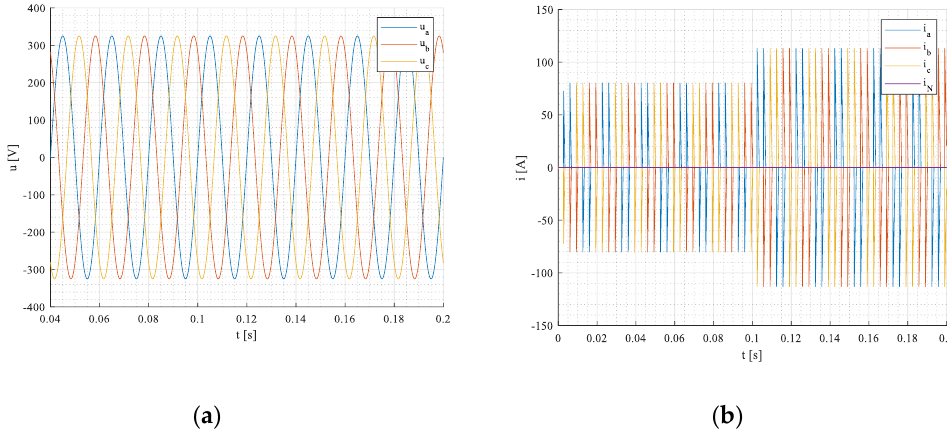
Figure 14. Network voltages ( a ) and currents ( b ) in 𝑎, 𝑏, 𝑐 - coordinate systems. Voltage (a) and current (b) on the DC side of the rectifier, under step change of resistive load, are shown in Figure 15a,b.